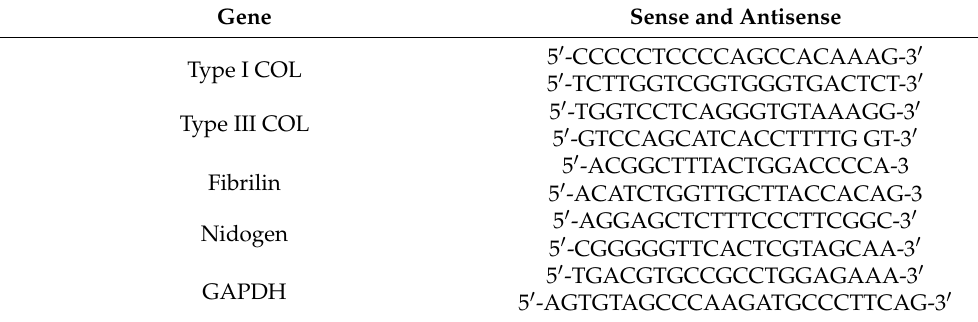
Table 1. Primer used for the analysis of expression by PCR. Gene Sense and Antisense Type I